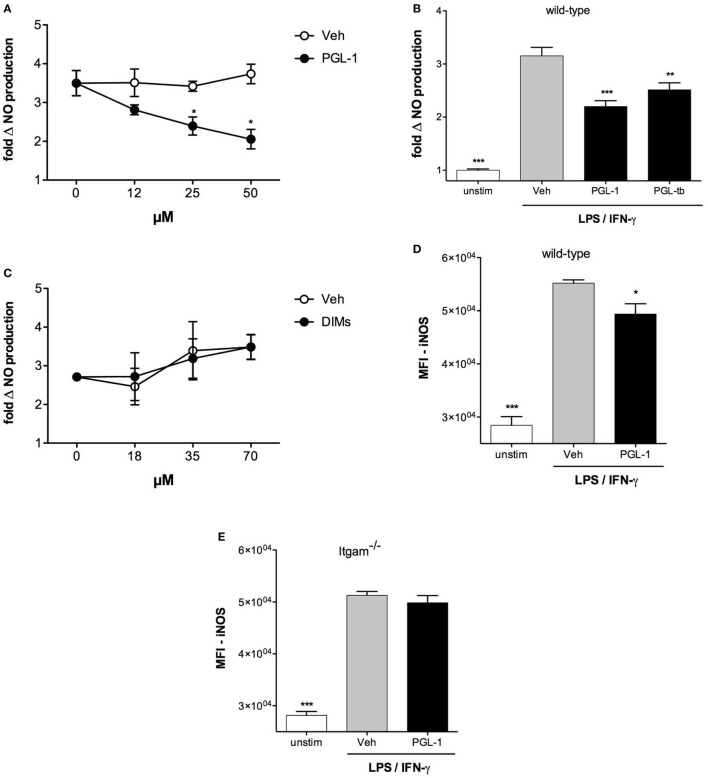
Phenolic glycolipids (PGLs) reduce LPS/IFN-γ-induced production of iNOS in a CR3-dependent manner. (A) Differential production of NO by bone marrow-derived macrophages (BMDMs) pretreated with increasing concentrations of PGL-1 or vehicle (Veh) for 24 h prior to a 24 h stimulation with 1 µg/ml LPS and 100 U/ml IFN-γ. Data are mean NO levels ± SEM (n = 4), expressed as fold changes relative to non-treated, stimulated controls. *P < 0.05, Mann–Whitney test comparing PGL-1-treated to vehicle controls at each concentration. (B) As in (A) with 25 µM PGL-1 or 25 µM PGL-tb; unstim: non-treated, non-stimulated controls. (C) As in (A), with increasing concentrations of dimycocerosates (DIMs). (D) Differential induction of iNOS in BMDMs exposed to 25 µM PGL-1 or vehicle (Veh) for 24 h prior to a 24 h stimulation with LPS/IFN-γ. Controls are non-treated, non-stimulated cells (unstim). Data are mean fluorescence intensities (MFI) ± SEM (n = 3). (E) As in (D) in Itgam−/− BMDMs. Data shown are from one experiment repeated twice with similar results. Statistical comparisons in (B,D,E) were performed with repeated measures ANOVA with Tukey post hoc test, relative to the vehicle-treated, LPS/IFN-γ-stimulated group. *P < 0.05, **P < 0.01, ***P < 0.001.